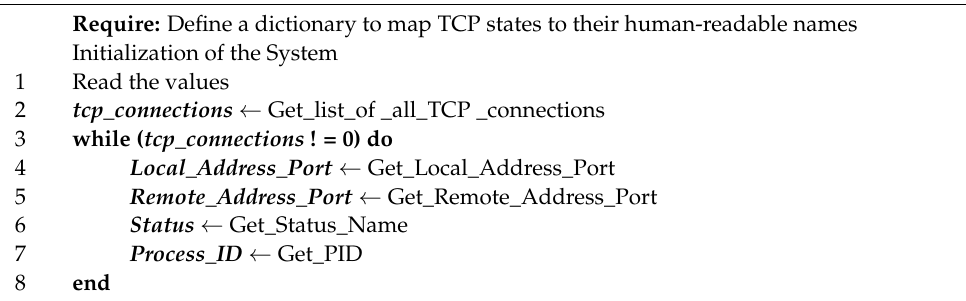
Algorithm 2: Observation of the Processes Pseudocode